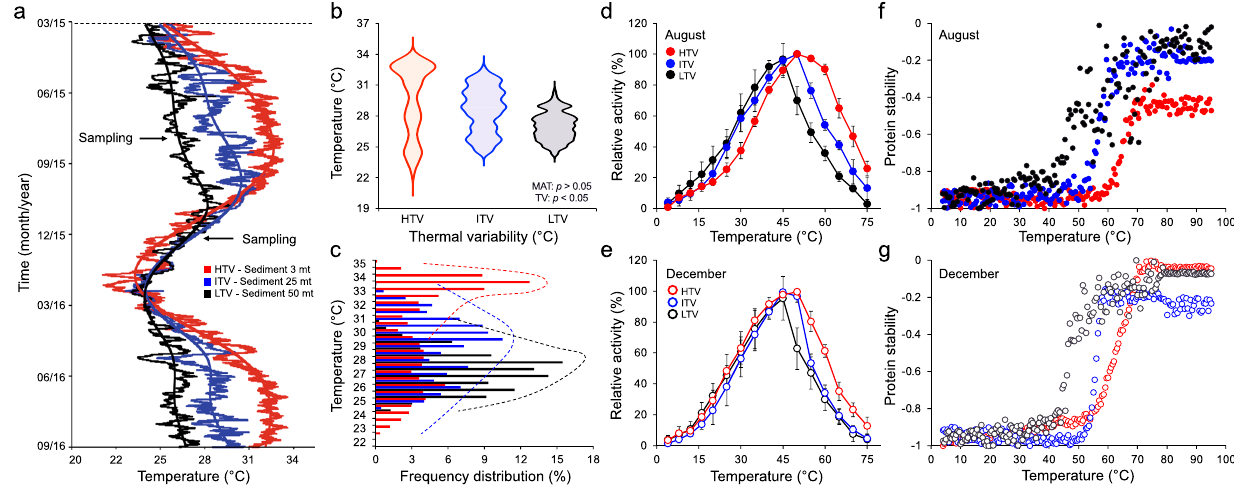
Fig. 3 | Thermal variability in Red Sea coastal sediments and metabolic response of associated bacterial communities. a Temperature monitoring over 18 months in high temperature variability (HTV, red), intermediate temperature variability (ITV, blue), and low temperature variability (LTV, black) sediments. Temperaturesareexpressedasaveragevaluesfromthethreestationsbelongingto each level of thermal variability (see Source Data). Black arrows indicate the sam- pling sessions. b Width of the temperature variability in the sediments from the three stations. The three sites do not show signi fi cantly different MAT (Dunnett ’ s multiple comparisons test, all p -values <0.05) but signi fi cantly different tempera- ture distribution ( i.e ., temperature variability; Levene ’ s test F 2,52700 =7328.2, p <2.2E-16). c Frequency distribution (percentages) of temperatures across